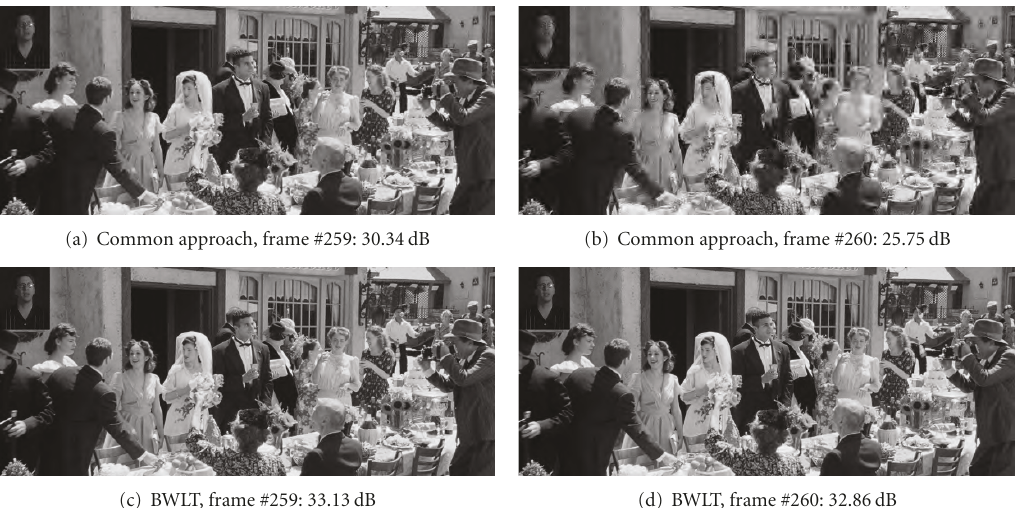
Figure 8: Visual comparison between BWLT (c), (d) and the common layer truncation (a), (b) for two frames of the “StEM” sequence. The common truncation produces irregular quality, which leads to flickering.